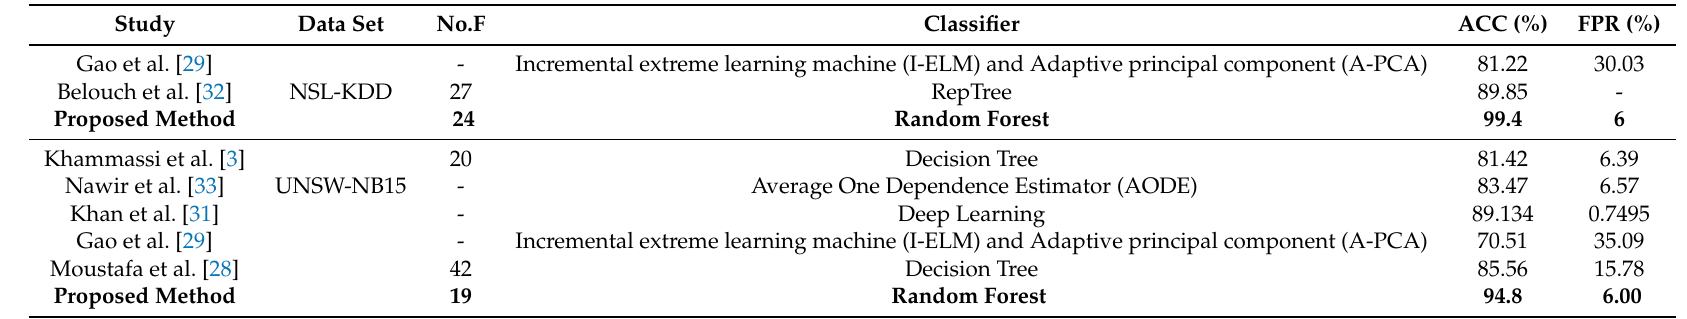
Table 13. The comparison of proposed model with the state-of-art on the NSL-KDD and UNSW-NB15